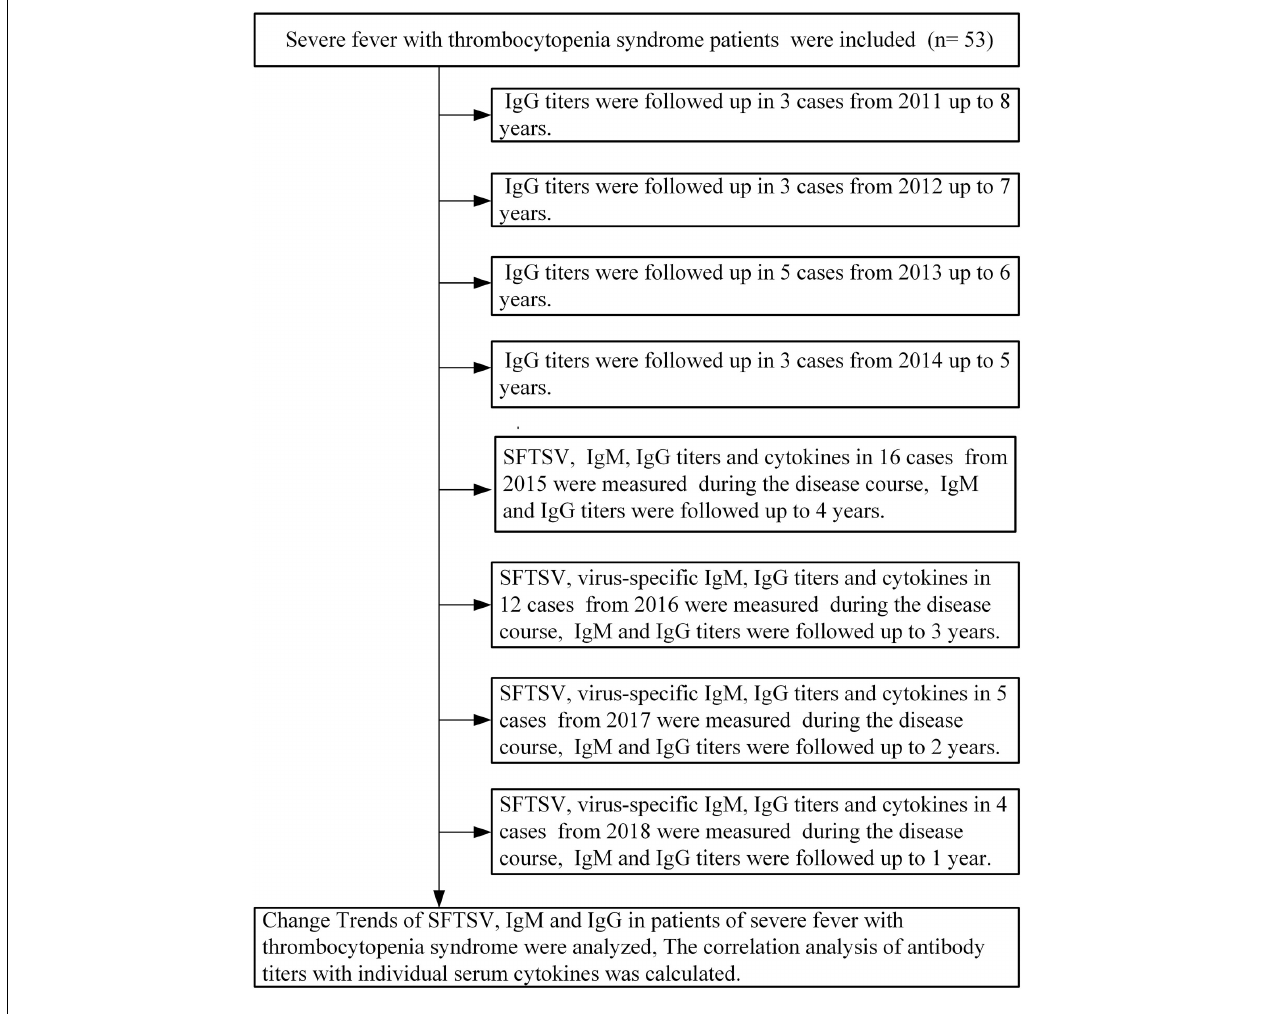
FIGURE 1 | Diagram flow of patients with severe fever with thrombocytopenia syndrome included in this research. SFTSV, severe fever with thrombocytopenia syndrome virus; IgM, immunoglobulin M; IgG, immunoglobulin G.